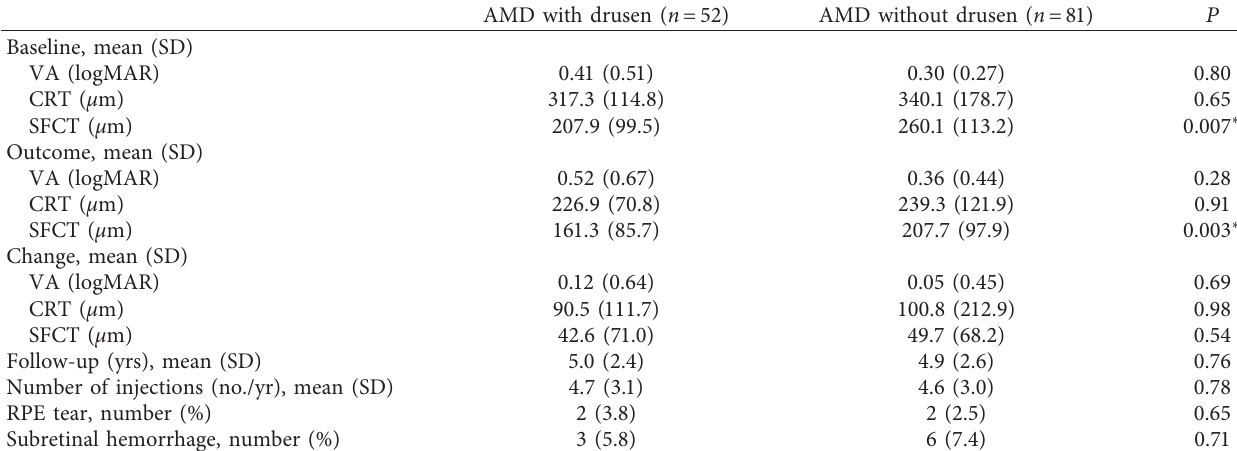
Table 2: Results of anti-VEGF therapy in nAMD with and without drusen.